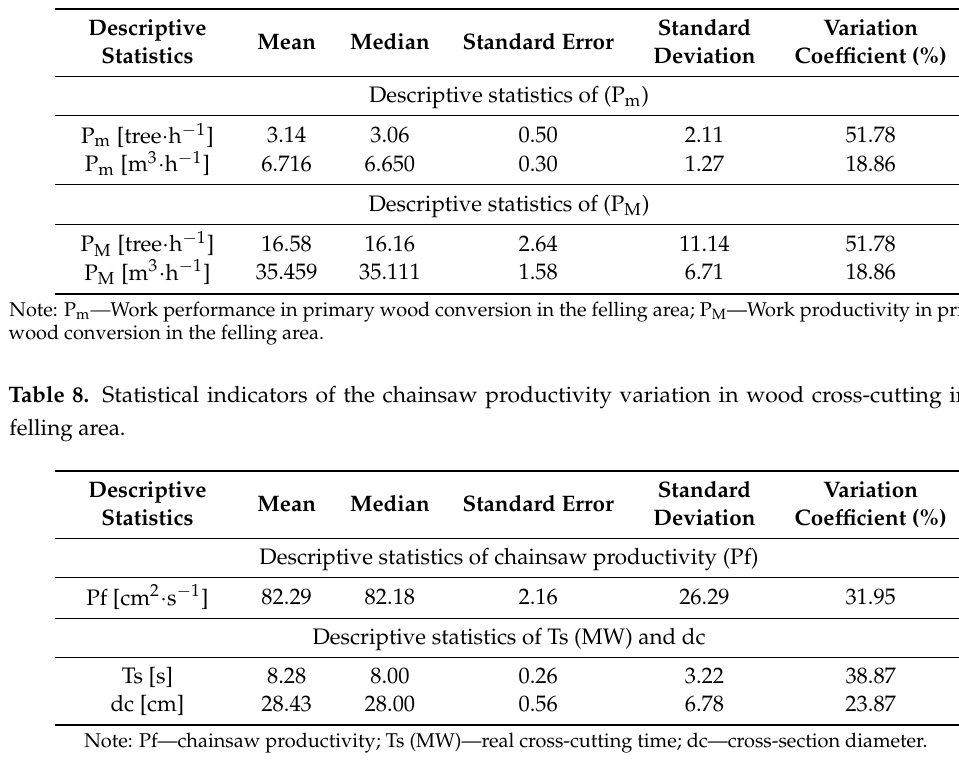
Table 7. Statistical indicators of the performance variation and work productivity in the primary processing of felled trees.